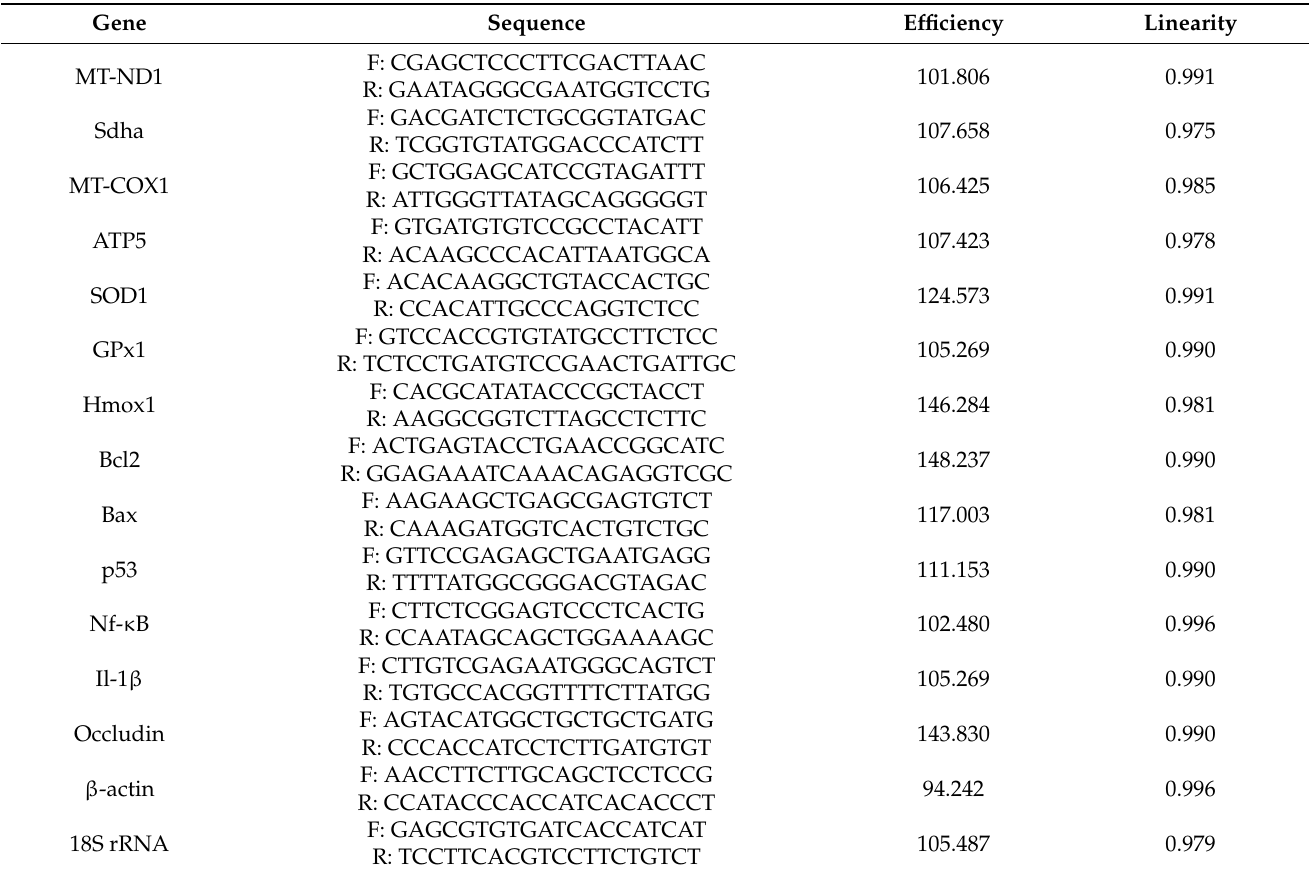
Table 2. Gene symbol, forward (F) and reverse (R) primers, efficiency and linearity of the selected genes plus reference genes β − actin and 18S